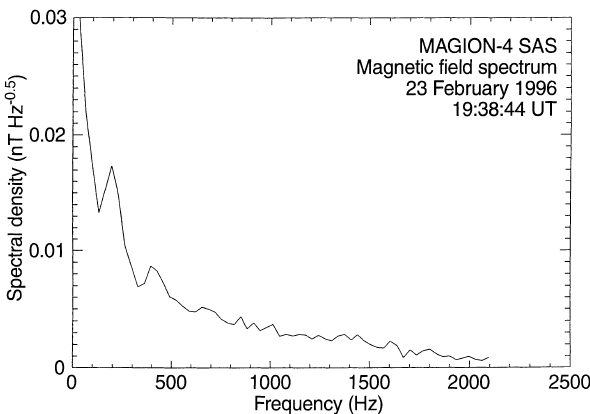
Fig. 3 . The spectrum of the magnetic-field ( B x -component) fluctua- tions taken within the plasma sheet. The maxima at 200 and 400 Hz correspond to the harmonics of electron gyro frequency